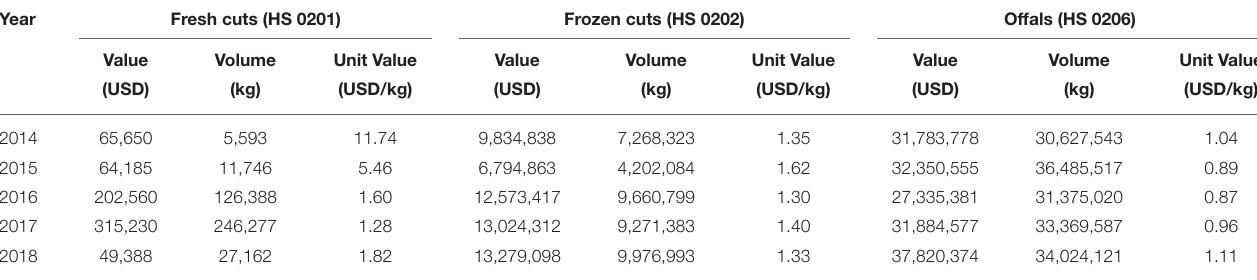
TABLE 2 | Exports of fresh and frozen beef products to Ghana,